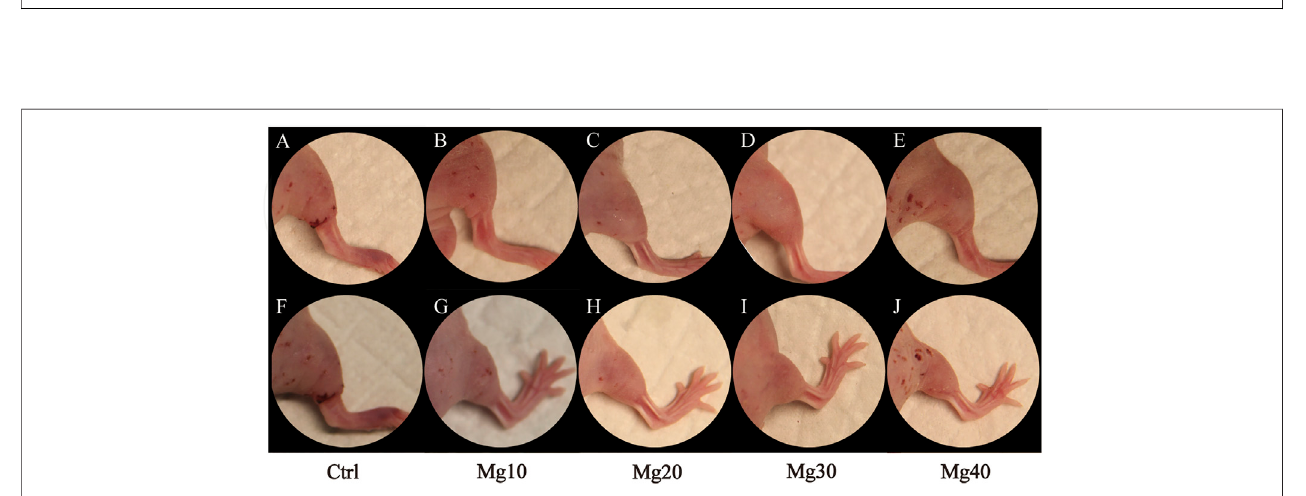
FIGURE 5 | Hindlimb edema model in nude mice (A – E) , and after treatment of MgSO 4 /MgO/SA/Na-CMC composite hydrogel dressings (F – J) .